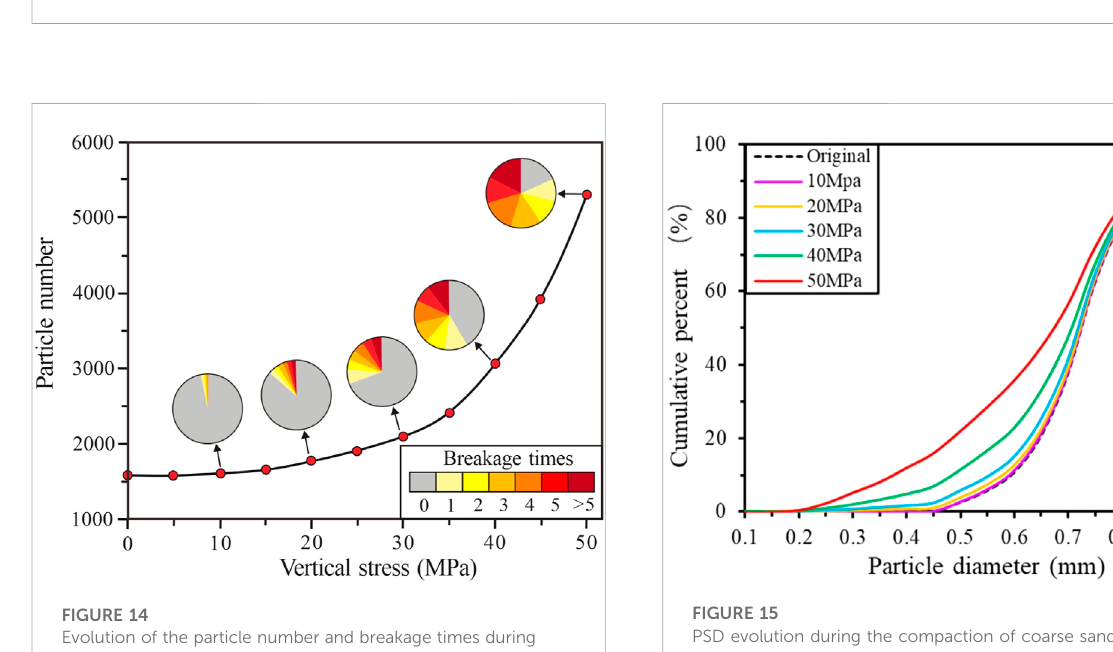
FIGURE 13 Simulation effect of the coarse sand sample.